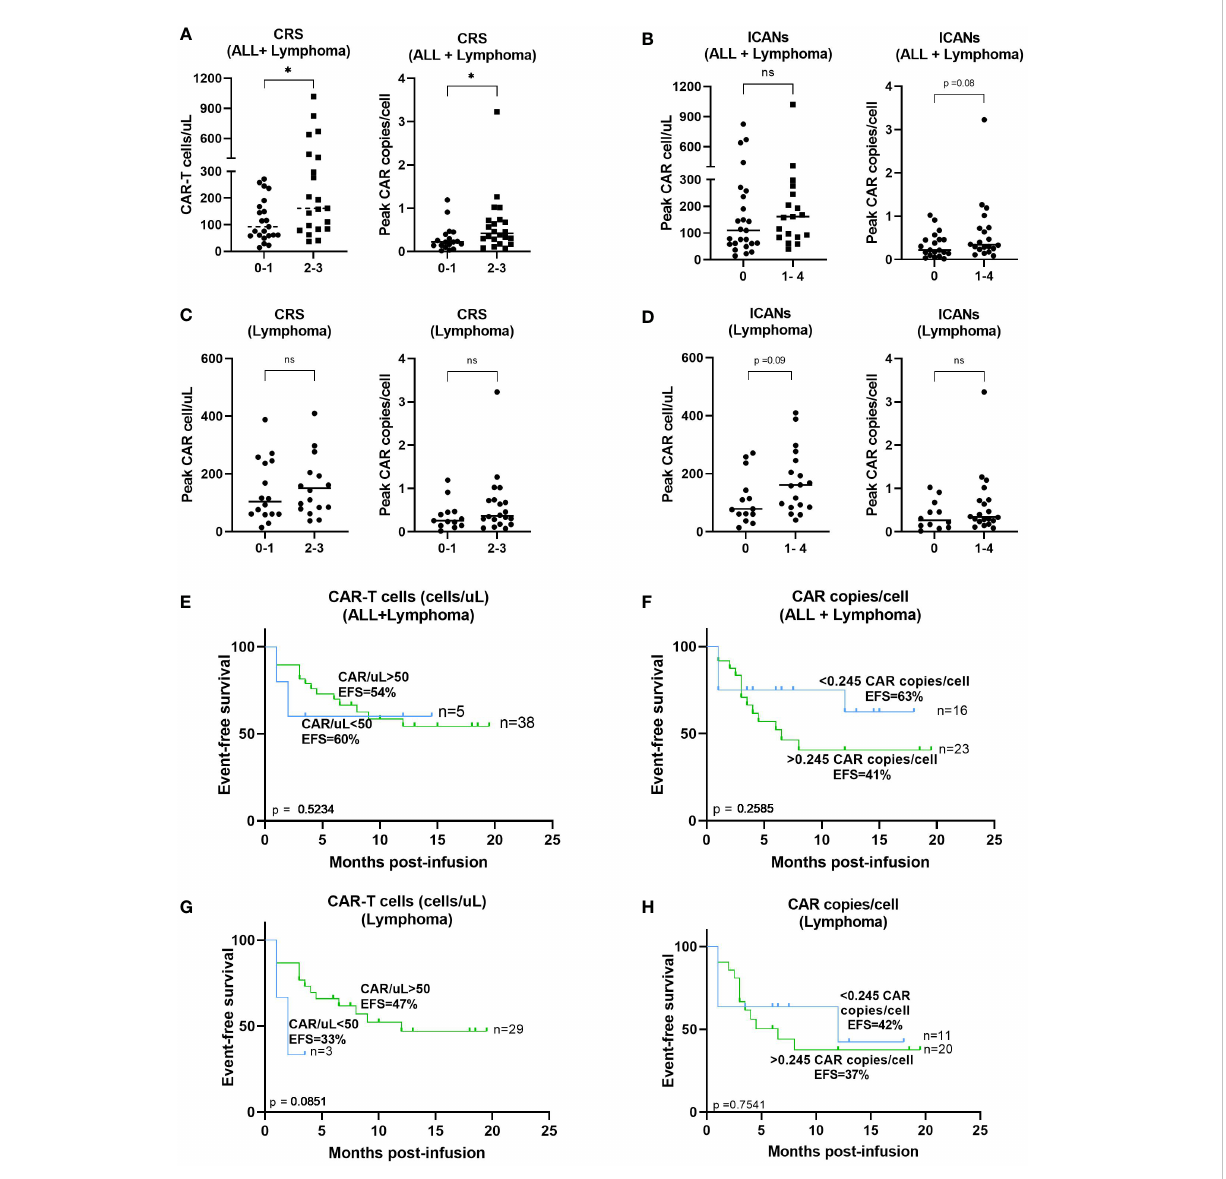
FIGURE 5 Correlation between CAR-T cell expansion in blood and toxicity or response. (A) Correlation between peak expansion by fl ow cytometry ( left) or dPCR (right) and severity of CRS from patients with B-ALL and lymphoma. (B) Correlation between peak expansion by fl ow cytometry (left) or dPCR (right) and incidence of ICANs from patients with B-ALL and lymphoma. (C) Correlation between peak expansion by fl ow cytometry ( left) or dPCR (right) and severity of CRS from patients with lymphoma excluding patients with B-ALL. (D) Correlation between peak expansion by fl ow cytometry (left) or dPCR (right) and incidence of ICANs from patients and lymphoma excluding patients with B-ALL. Correlation between absolute CAR-T cell count (E) or CAR copies/cell (F) and event free survival of all patients or (F) excluding patients with B-ALL (G, H) . Depicted are median and individual values of the forty-eight samples. P-values between the indicated groups were calculated using unpaired Mann-Whitney U-t tests. ns: non- signi fi cant, *p<0.05. Correlation studies were performed using Kaplan-Meier survival